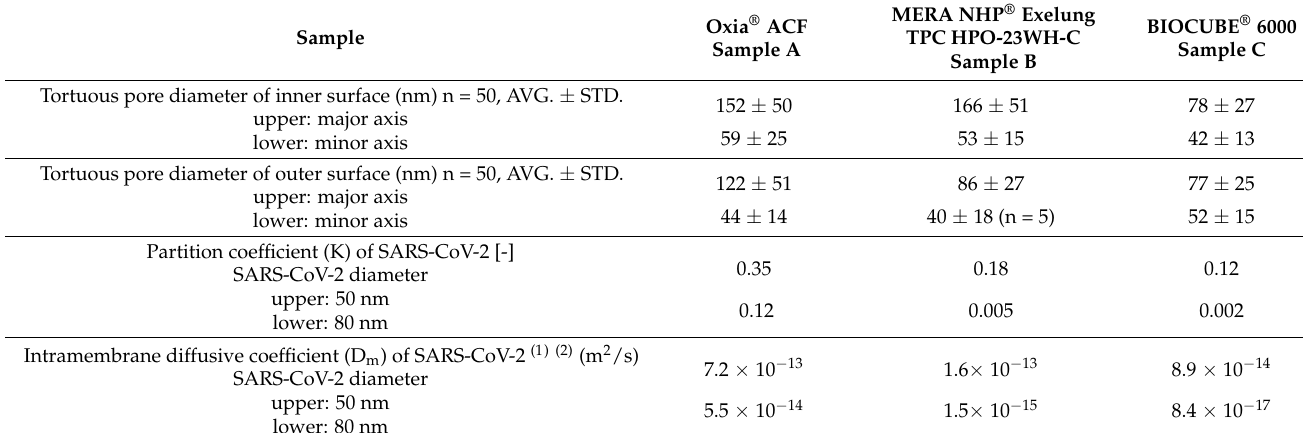
Table 2. Pore diameter of ECMO membranes and SARS-CoV-2 permeability. Sample